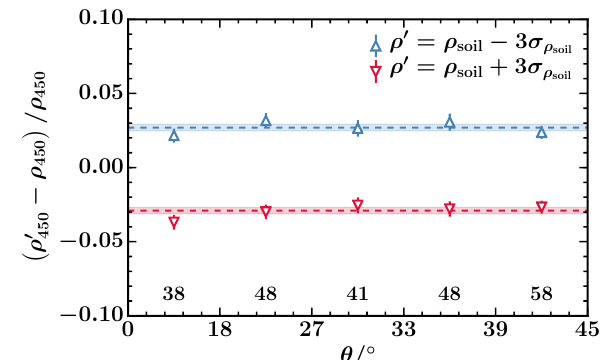
Figure 5: Relative di ff erence of the reconstructed ρ thr ues to ρ 0 . 3 V SPE (obtained for the target threshold of 0 . 3 V SPE ) 450 as a function of the discriminator threshold. Markers show the mean relative di ff erence, error bars denote the standard error of the mean. A linear fit (black solid line) yields a systematic uncertainty of 3 . 9% for a 2 σ variation of the target threshold.